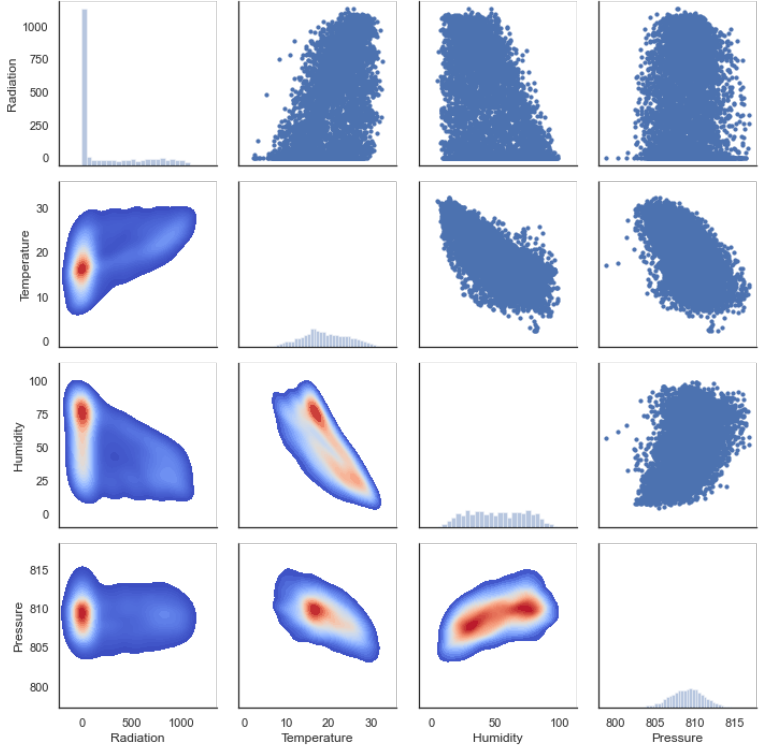
Figure 6. Scatter plots of SR as a function of various